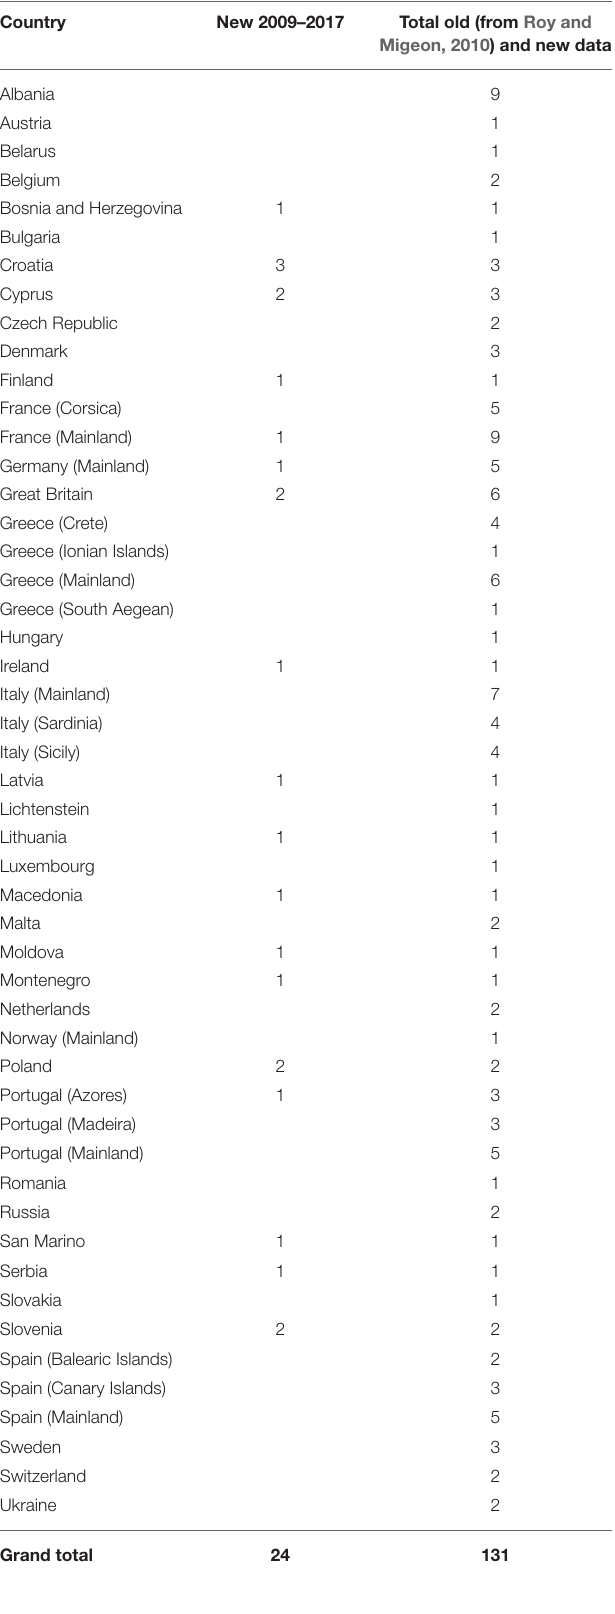
TABLE 1 | Numbers of newly reported (i.e., in literature from 2009 to 2017) and total alien ladybird species in European countries.